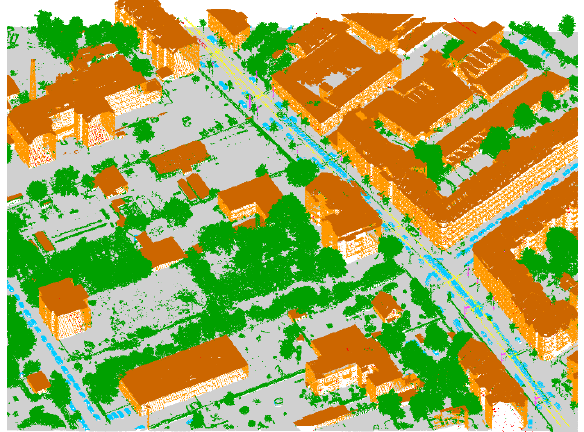
Figure 1 . Classification results of an ALS 3D point cloud using KPConv showing misclassifications on large building